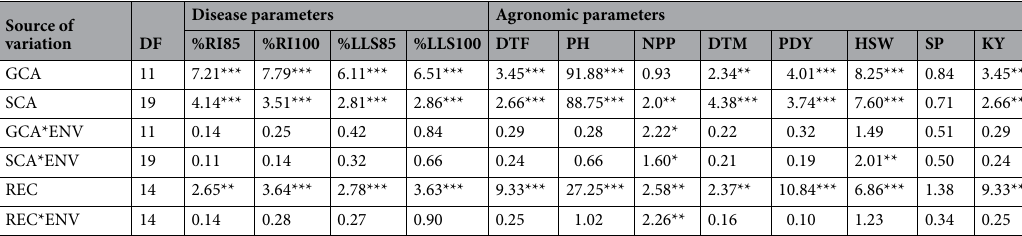
Disease parameters